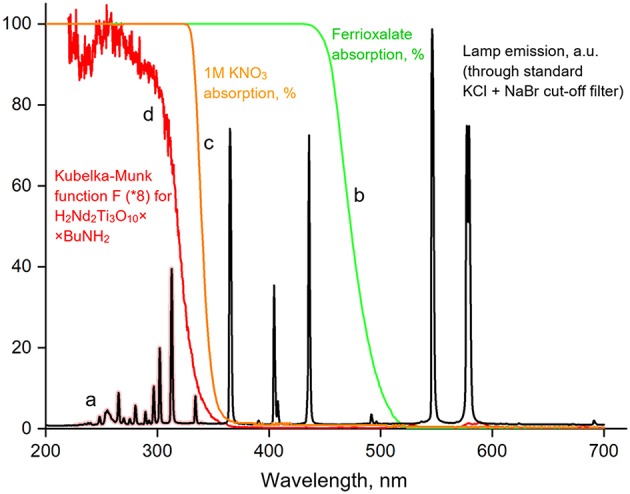
Emission spectrum for the DRT-125 lamp used for photocatalytic experiments (a), absorption of the light-sensitive potassium ferrioxalate solution used for light intensity measurements (b), absorption of the additional KNO3 cut-off filter (c), absorption of the H2Nd2Ti3O10×BuNH2 photocatalyst expressed by the Kubelka-Munk function (d).